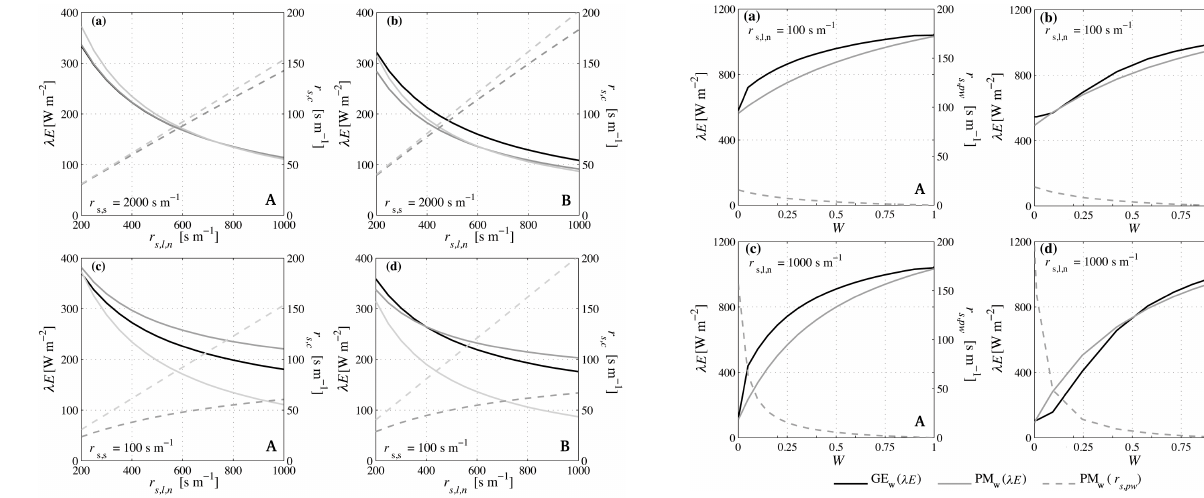
Fig. 3. For a dry canopy, latent heat flux ( λE) and canopy surface resistance ( r s,c ) as a function of minimal stomatal resistance ( r s,l,n ) (Eq. C8) representing the canopy water stress. Comparison of three methods (GE d , SE d , PM d ) for two profiles of leaf area density ( A and B ) and two different values of soil surface resistance: (a) and (b) r s,s = 2000sm − 1 (dry soil); (c) and (d) r s,s = 100sm − 1 (moist soil).